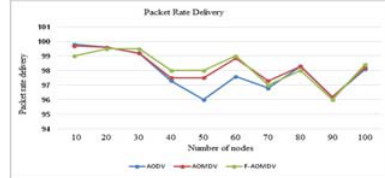
Fig. 7. The performance